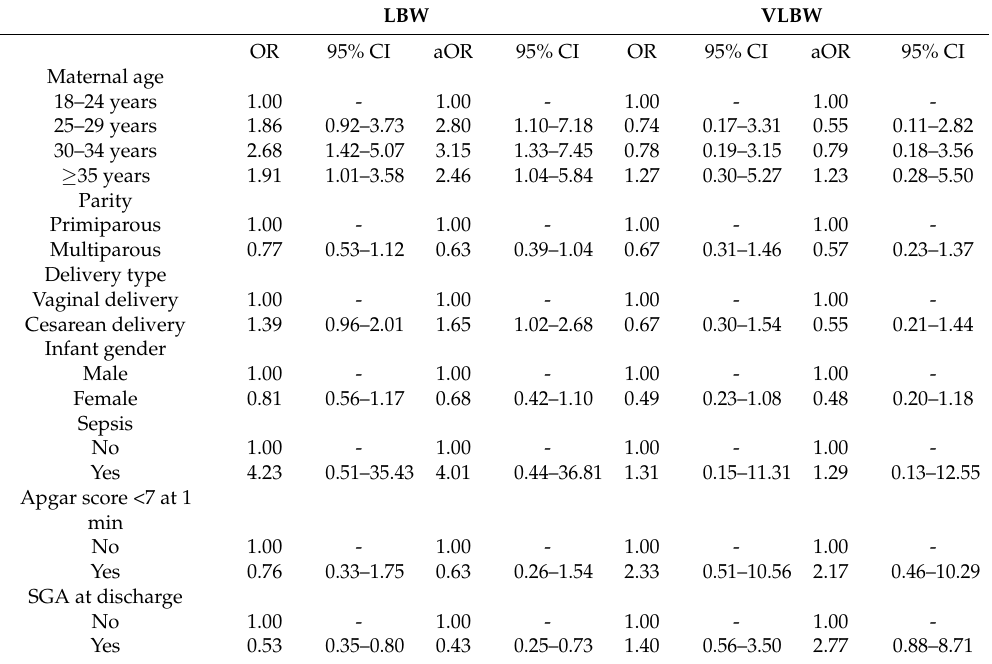
Table 2. Unadjusted and adjusted odds ratios for breastfed infants by participants’ characteristics.